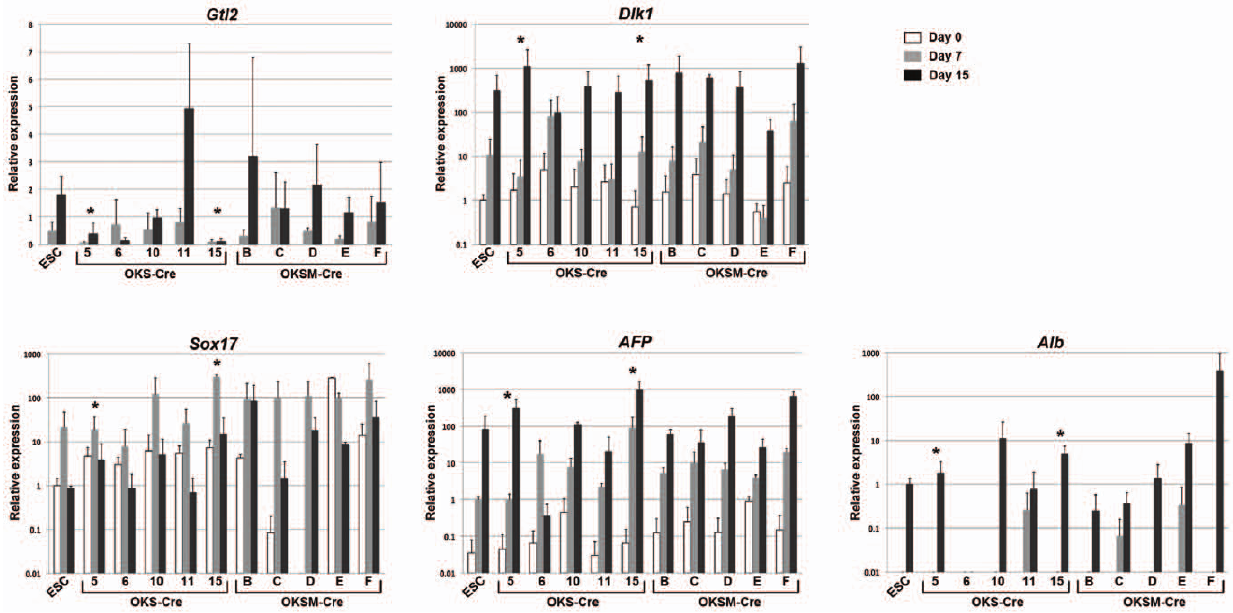
Figure 4. Directed differentiation of transgene-free iPSCs into hepatic progenitors is not affected by the epigenetic status of the Dlk1-Dio3 gene cluster. qRT-PCR analysis of the differentiating cultures at different time points demonstrates induction of the endoderm marker Sox17 followed by an increase in expression of the liver markers AFP and albumin. Remarkably, all iPSC clones displayed an in vitro differentiation capacity comparable to ESCs regardless of the expression levels of Gtl2 and Dlk1